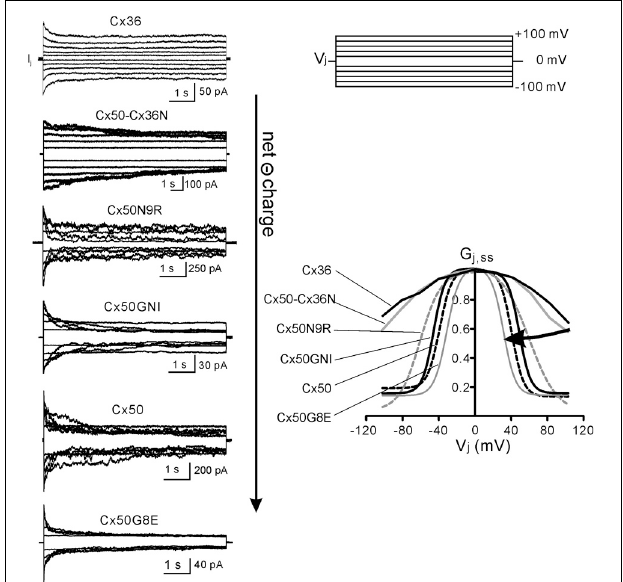
FIGURE 2 | V j -gating of Cx36, Cx50, and the selected Cx50 NT mutants. Left panel: superimposed junctional currents ( I j s ) in response to transjunctional voltage ( V j ) pulses ( ± 20 to ± 100mV at 20mV increment, shown on top Right panel) are illustrated. Each set of record was recorded from a pair of N2A cells expressing Cx36, Cx50-Cx36N, Cx50N9R, Cx50GNI, Cx50, and Cx50G8E as indicated. Right panel: steady-state junctional conductance, normalized to the peak junctional conductance (defined as G j , ss ), was plotted as a function of V j . The G j , ss – V j plots of Cx36 and Cx50-Cx36N are directly from the experimental measurements, while the rest of the plots (smooth lines or dashed lines) are Boltzmann fittings from experimental data. With the increase of net charge negativity, the bell-shaped G j , ss – V j curves are getting narrower or with a lower values of V 0 (half inactivation voltage in Boltzmann fitting). The data on Cx50, Cx36, Cx50-Cx36N, and Cx50N9R are from Xin et al. (2010) and the data on Cx50GNI and Cx50G8E are from Xin et al. (2012a) with